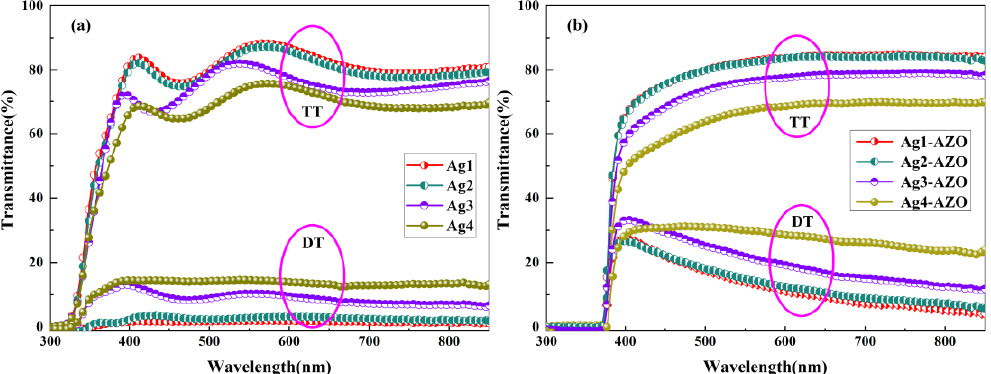
Figure 3. TT and DT spectra of ( a ) Ag NWs films on the AZO SL and ( b ) Ag NWs/AZO NRs composite films.